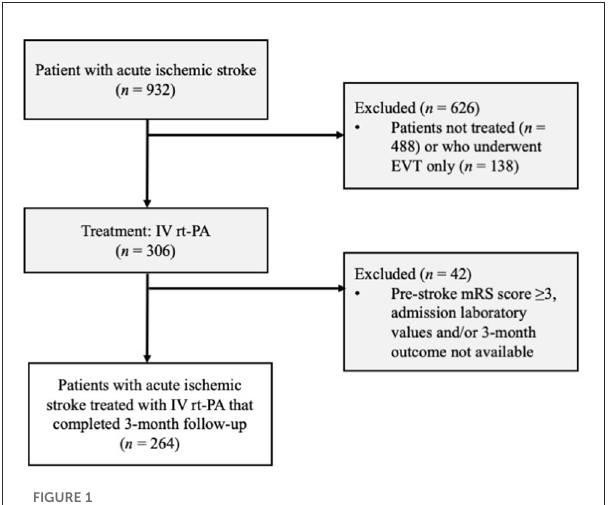
FIGURE1 Patient selection flow diagram. EVI, endovascular treatment; IVT rt-PA, intravenous thrombolysis with recombinant tissue plasminogen activator; mRS; modified Rankin